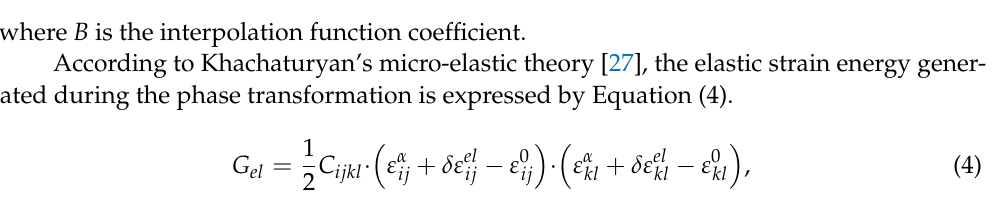
where B is the interpolation function